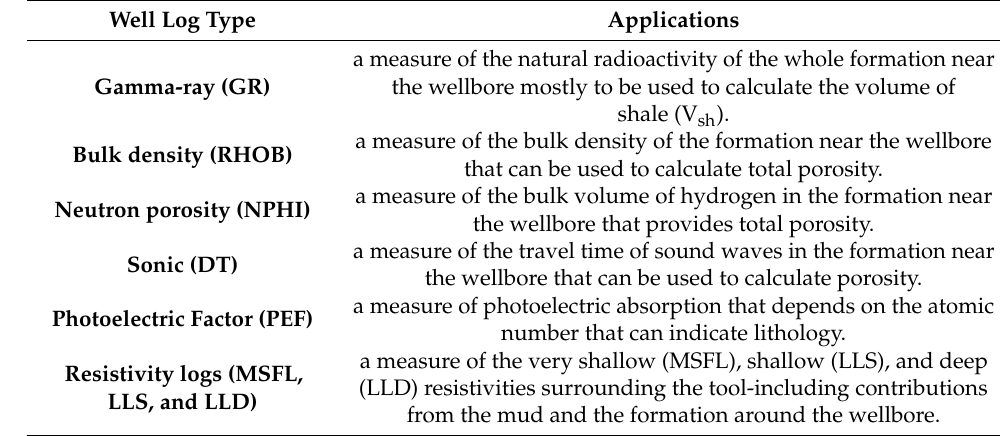
Table 2. A list of typical well logs and their general